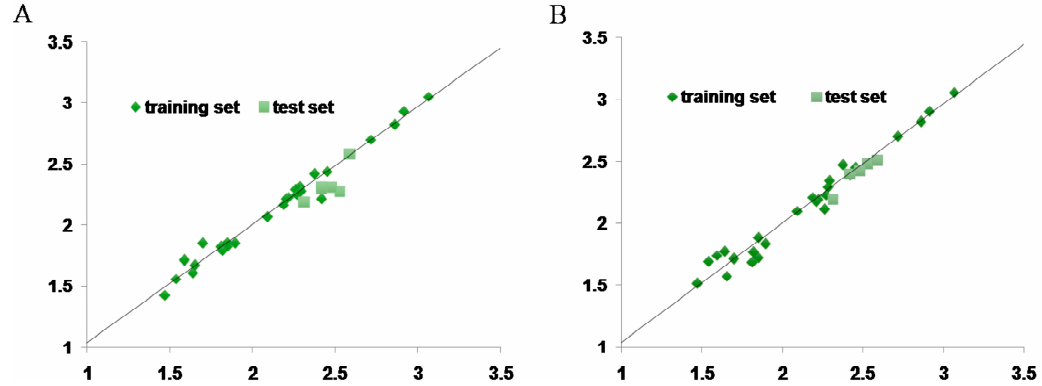
Figure 9. Plots of experimental activity [log (1/LC 50 )] against activity as predicted using CoMFA- ( A ) and CoMSIA-derived ( B ) models.